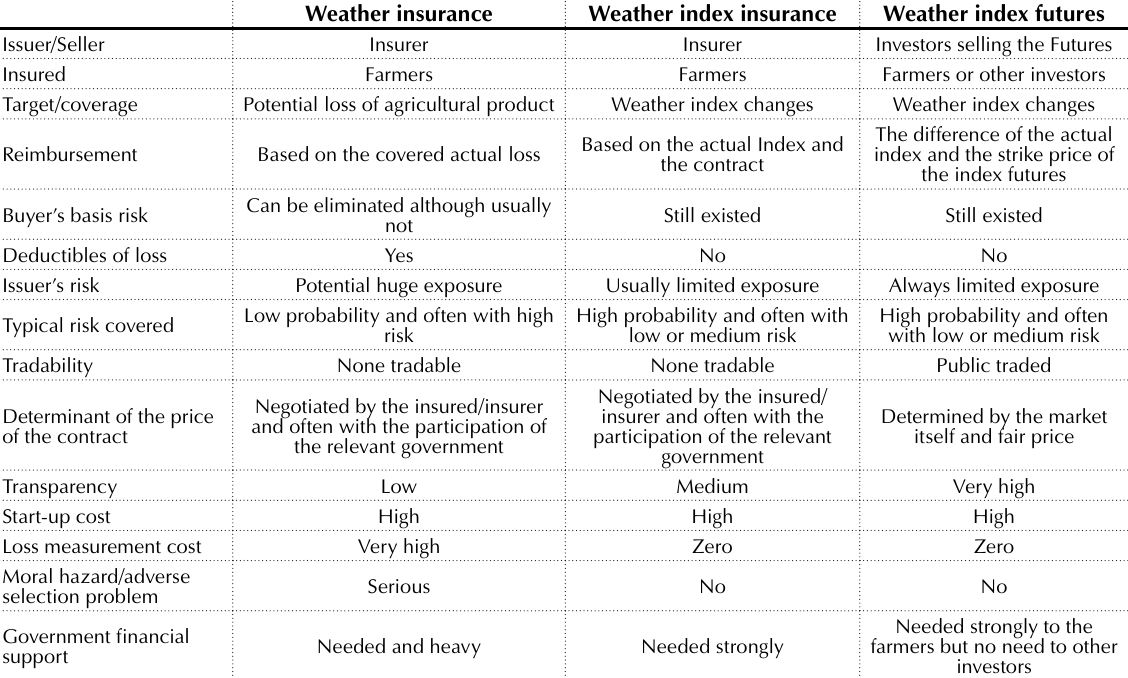
Table 1. Summary of weather insurance, weather index insurance and weather index